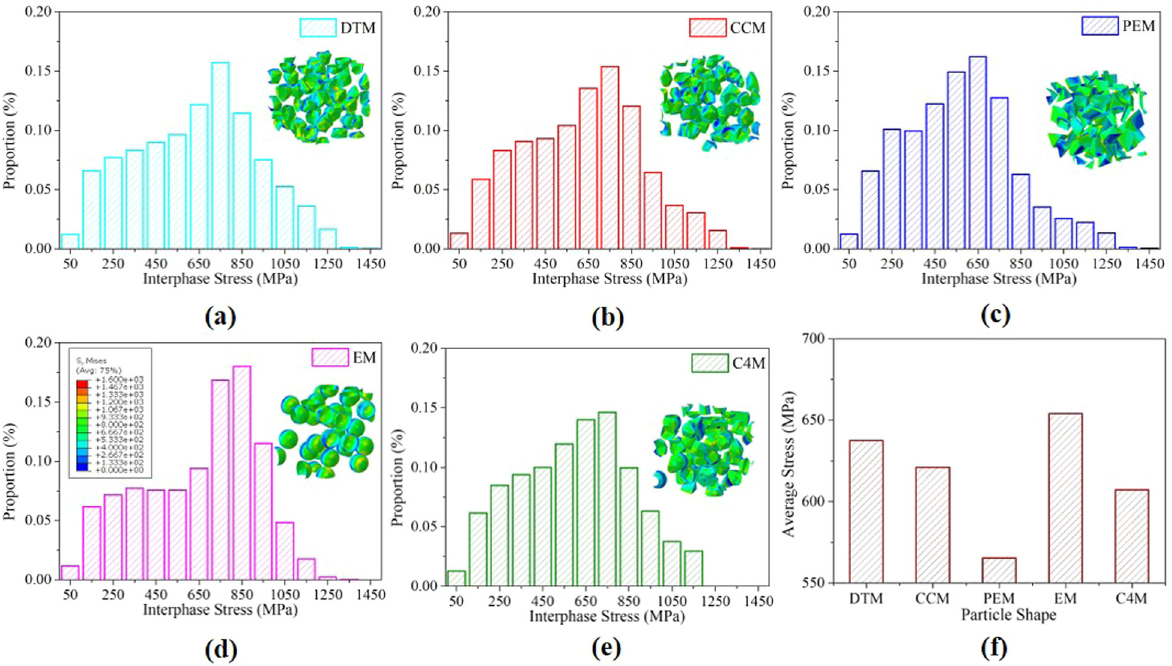
Figure 12: Interphase micro - stress distribution at 1% strain: ( a ) DTM, ( b ) CCM, ( c ) PEM, ( d ) EM, ( e ) C4M, and ( f ) mean stress of